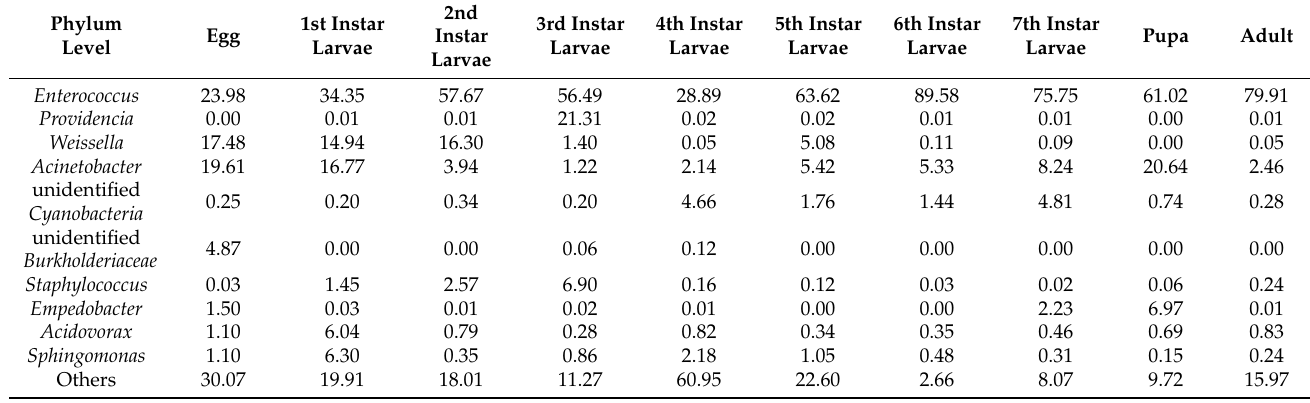
Table A4. The top 10 genera with the highest relative abundance levels for the gut microbiota of L. xylina during different developmental